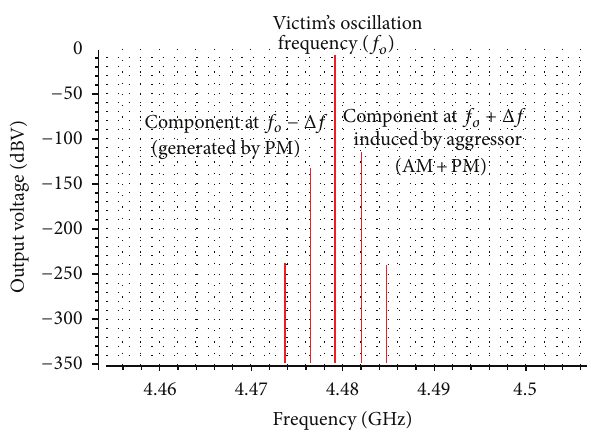
Figure 3: The victim VCO oscillates at 𝑓 𝑜 = 4.477 GHz, while an aggressor oscillating at 𝑓 𝑜 + Δ𝑓 = 4.479 GHz induces sidebands at (4.479 GHz–4.477 GHz) = 2 MHz away from the victim VCO. Note that the first upper sideband (at the aggressor frequency) is explained by constructive addition of AM and PM components and is larger in magnitude than the first lower sideband.